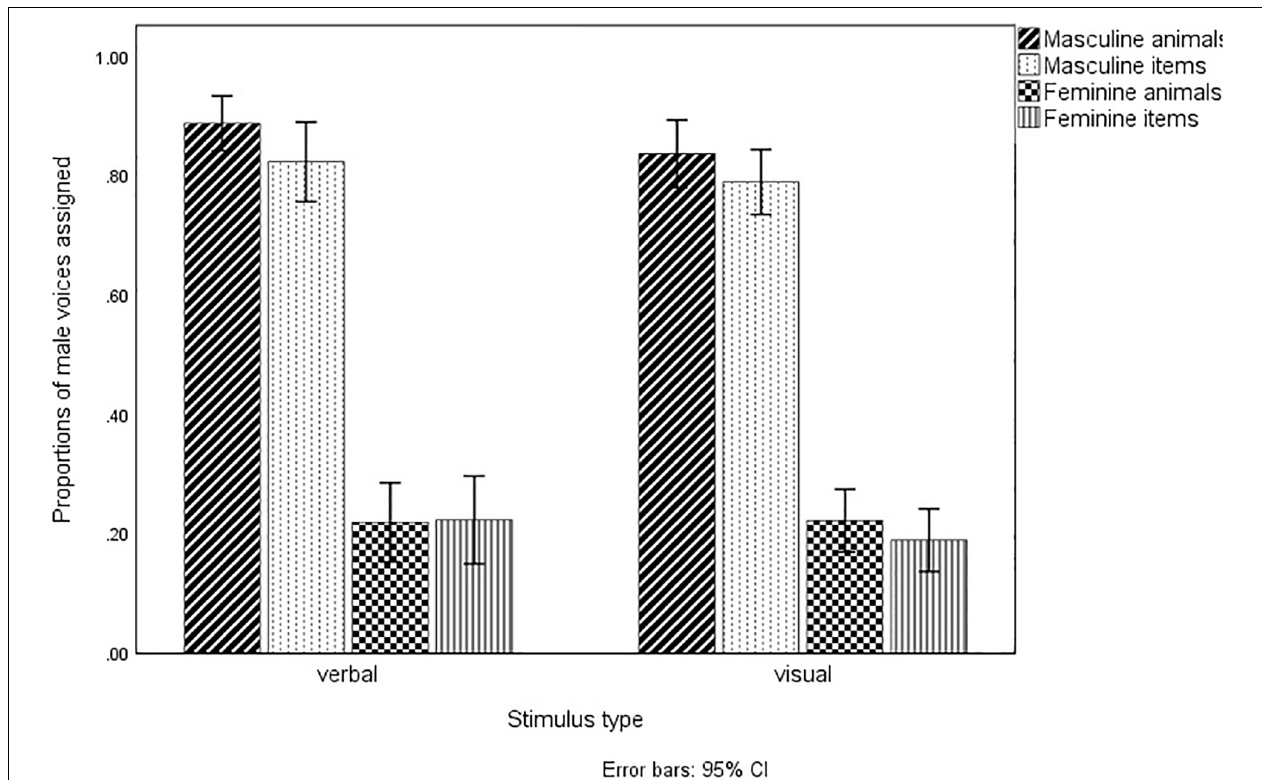
FIGURE 4 | Proportions of male voices assigned by grammatical gender and stimulus